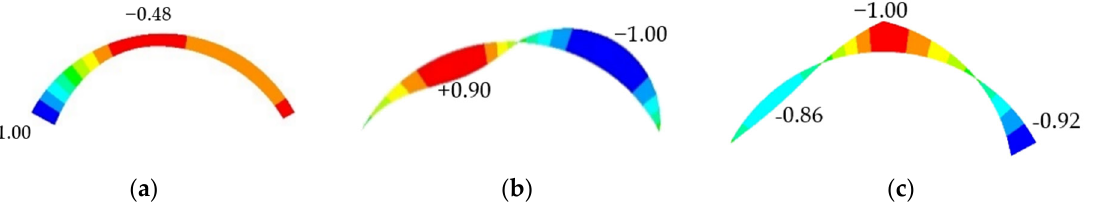
Figure 30. Distribution law of the internal force of arch under HSUVL: ( a ) axial force; ( b ) bending moment; ( c ) shear force.